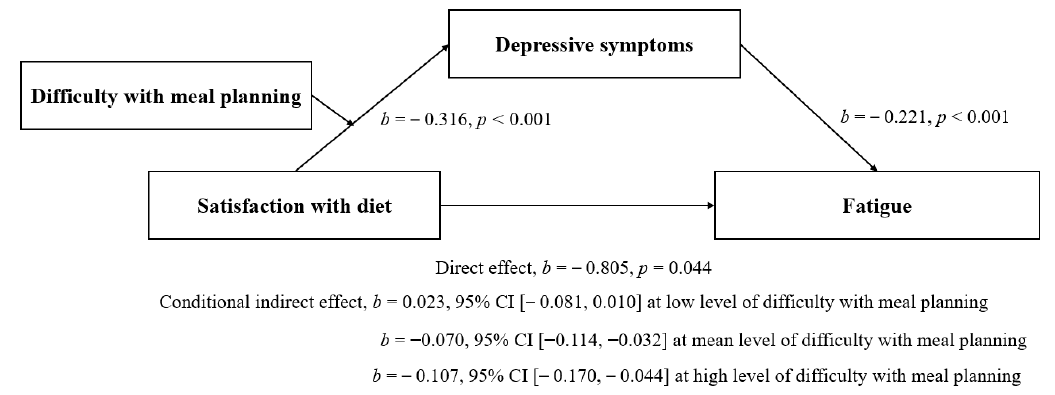
Figure 2. The moderated ‐ mediation effect of difficulty with meal planning on the relationship between satisfaction with diet and fatigue through depressive symptoms in a sample of older adults with diabetes. Note: b = − 0.147, p = 0.194 for low level of difficulty with meal planning; b = − 0.316, p < 0.001 for mean of difficulty with meal planning; b = − 0.484, p < 0.001 for high level of difficulty with meal planning.